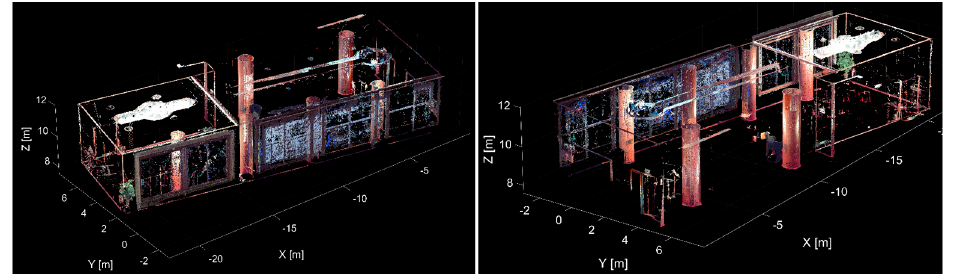
Figure 9. The remaining point cloud after the plane segmentation.